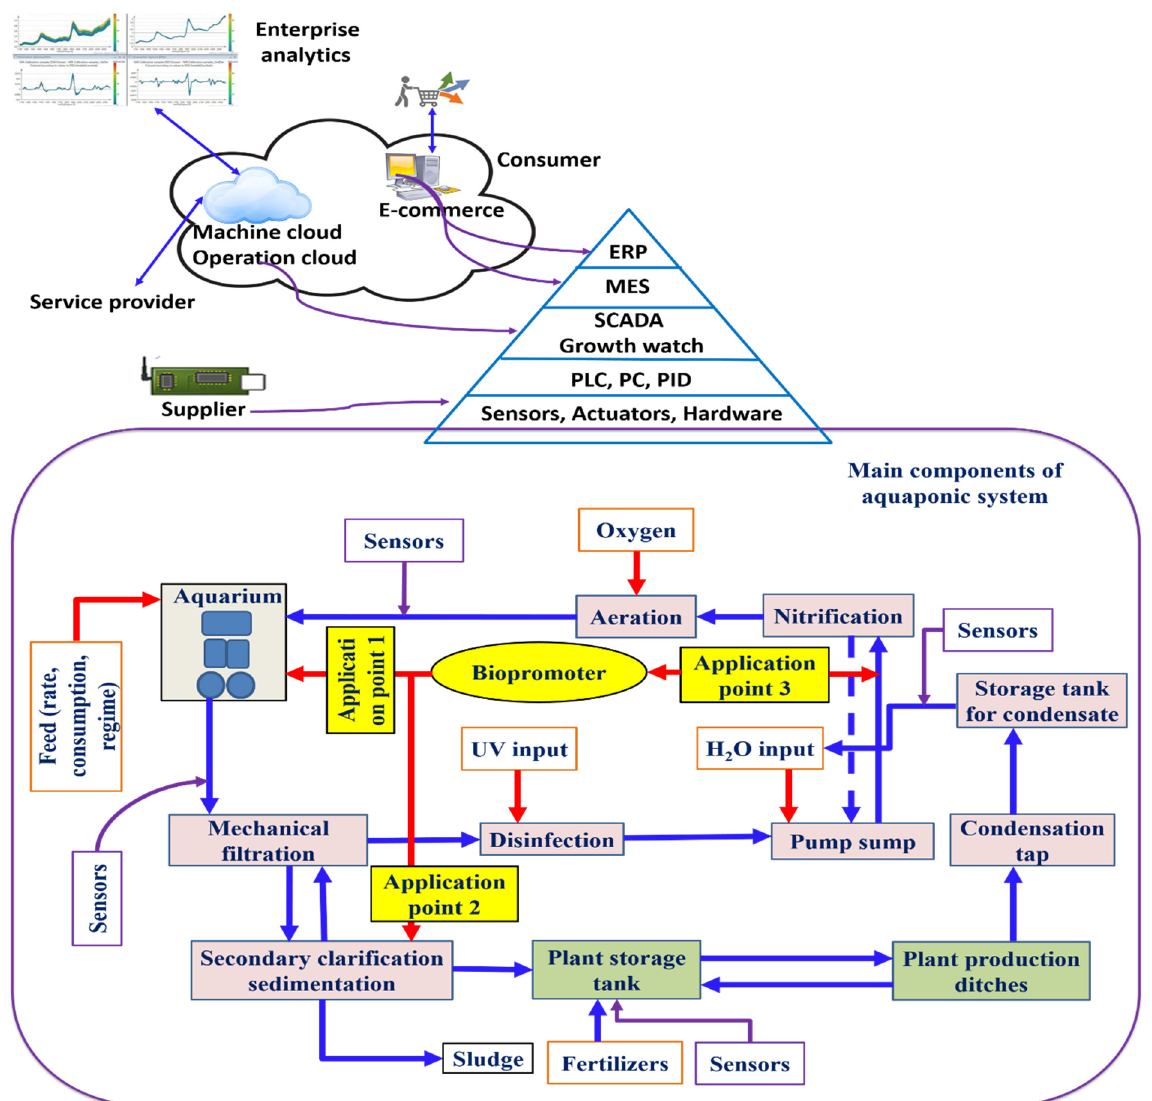
Figure 10. The future for aquaponics process automation systems with IoT.